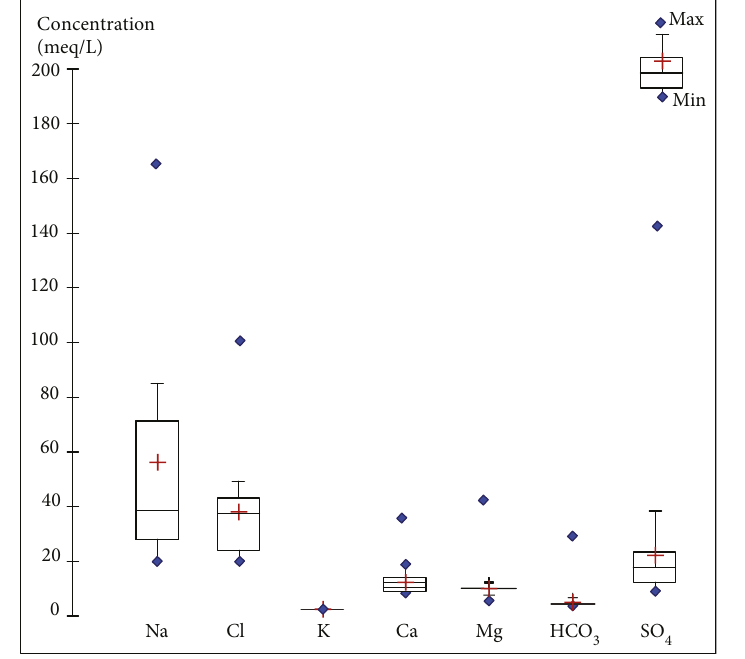
Figure 7: Box plot of major elements of the Skhira